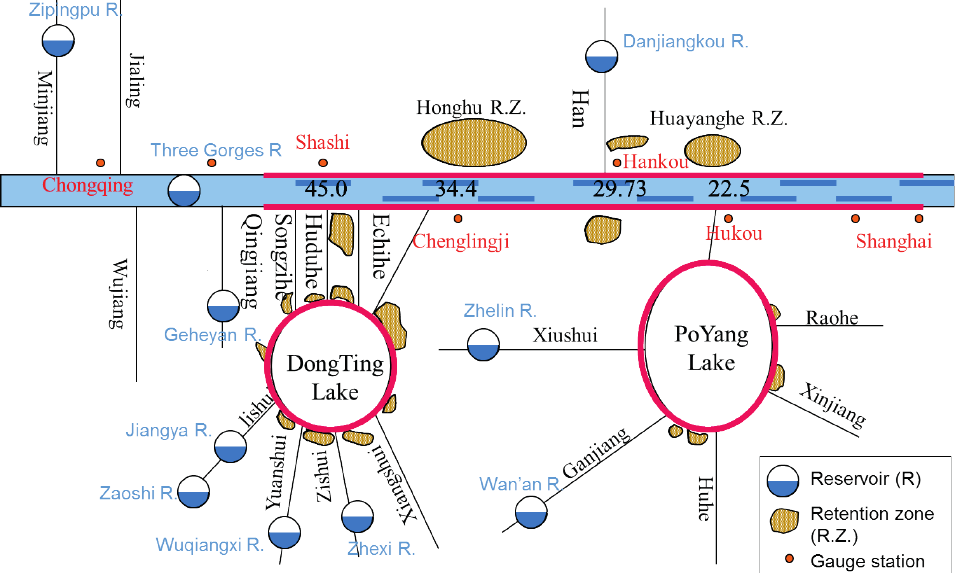
Fig. 3 Combination of engineering measures for flood management of Changjiang